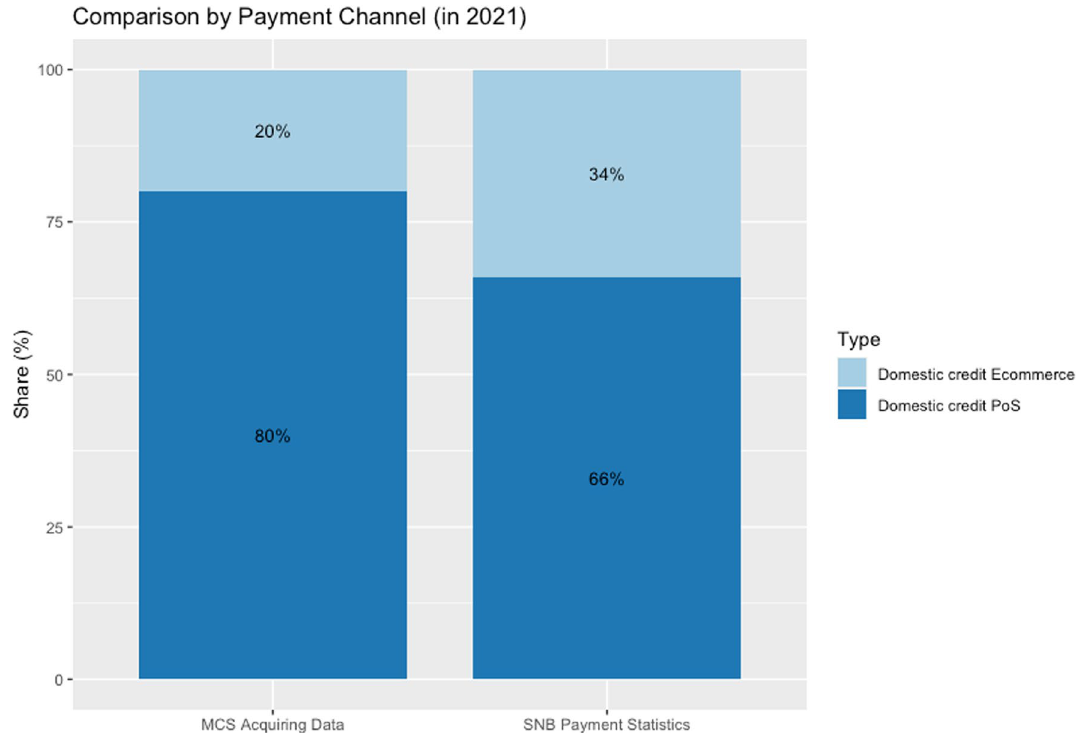
Fig. 5 Comparison of MCS acquiring data to SNB payment statistics, 2021. Note : The figure displays the distribution of payment channels in the acquiring data against the official distribution of payment channels in Switzerland according to SNB. Data source: MCS_Overview_Data.csv, SNB Payment and Cash Withdrawals (https:// data. snb. ch/ en/ topics/ finma/ cube/ zavez